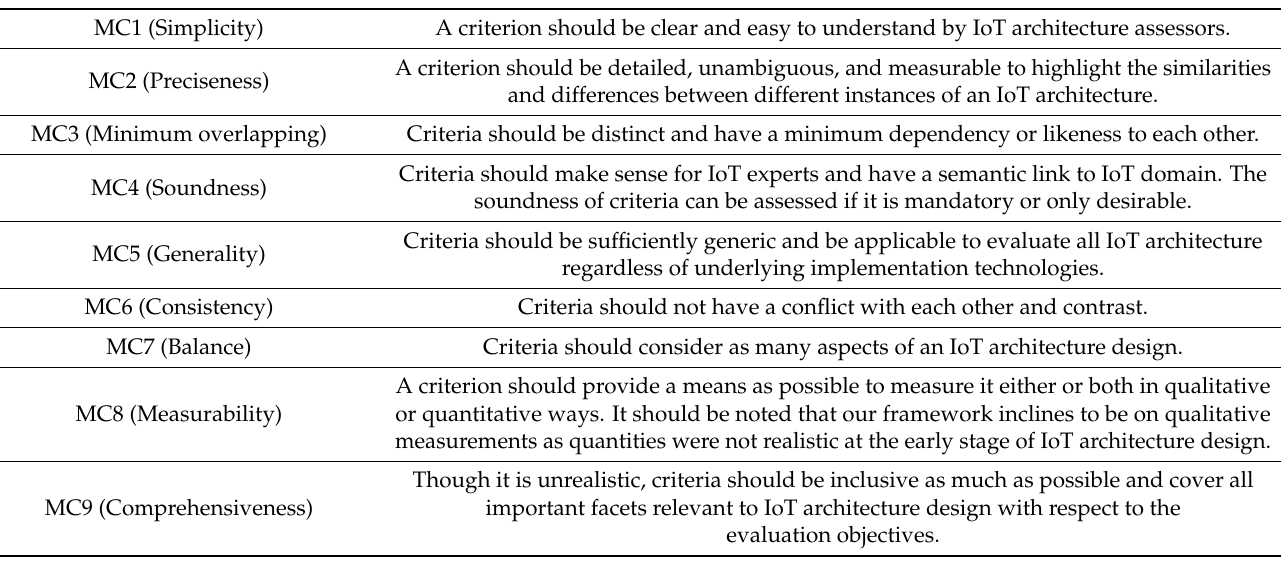
Table 1. MCs were anchored during the development, validation, and evaluation of criteria. MC1 (Simplicity)